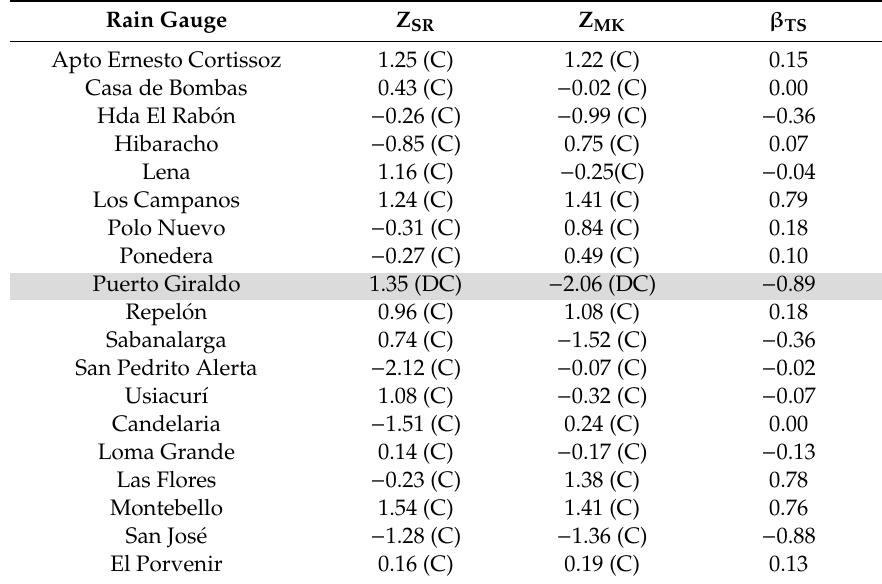
Table 4. Seasonal